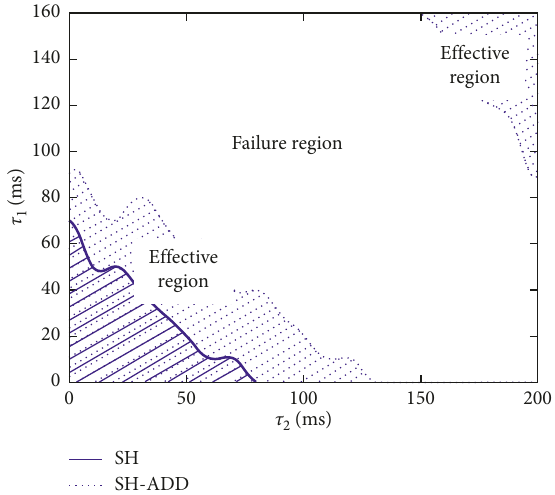
Figure 28: Time delay boundary curves of SH and SH-ADD controls when the velocity is